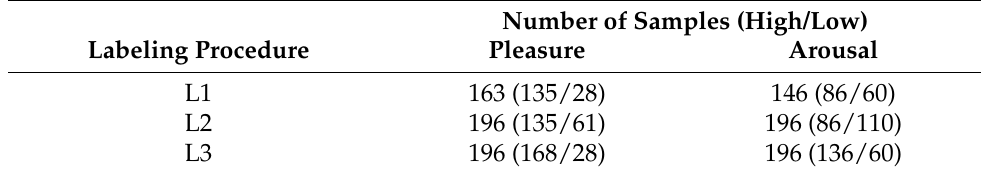
Table 8. Labels (class) distribution for different merging